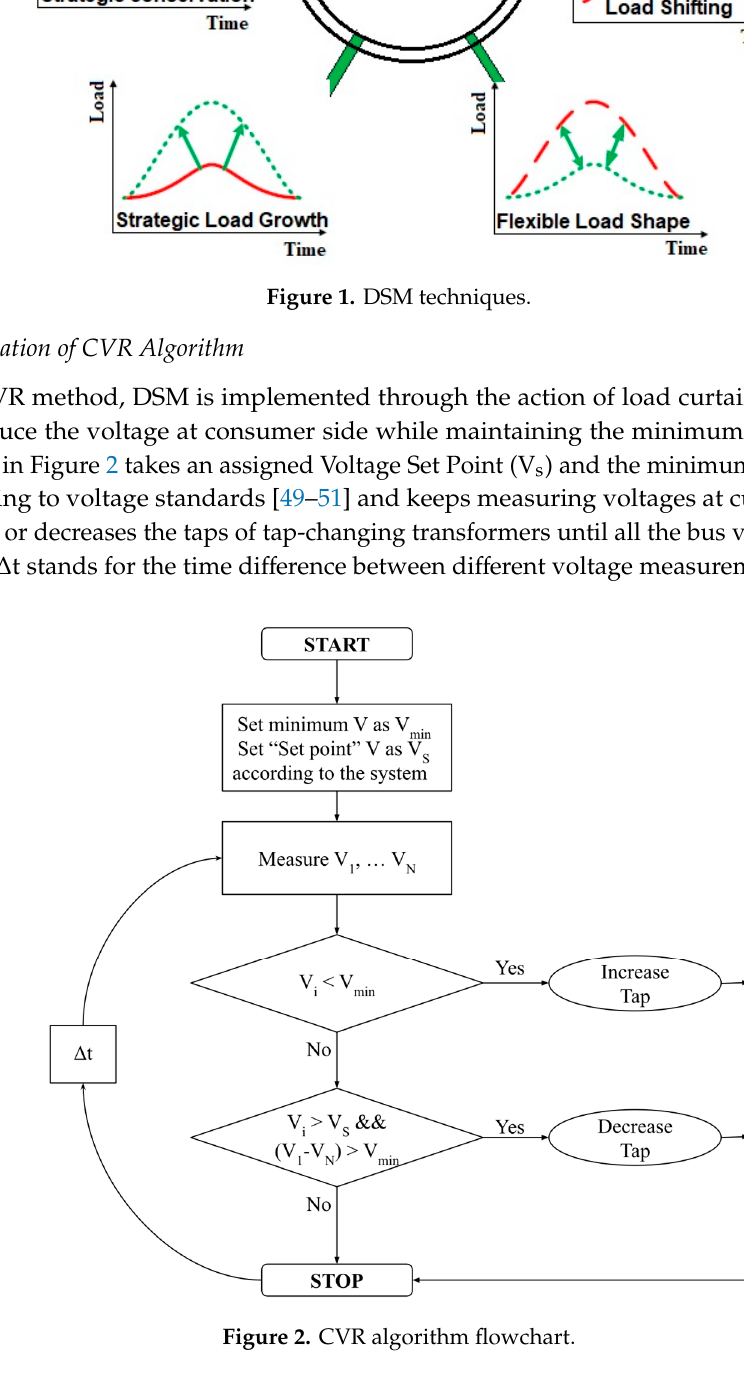
Figure 2. CVR algorithm flowchart.